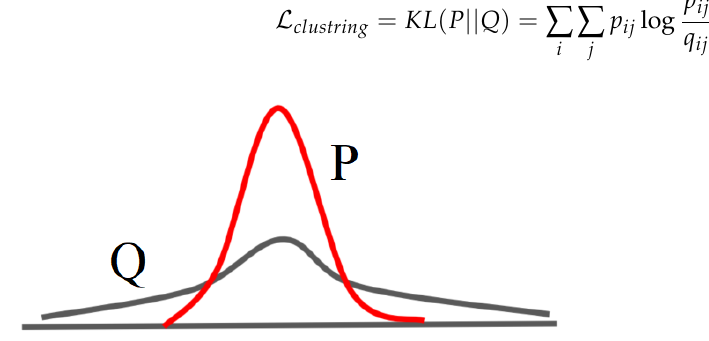
Figure 5. Target distribution and auxiliary